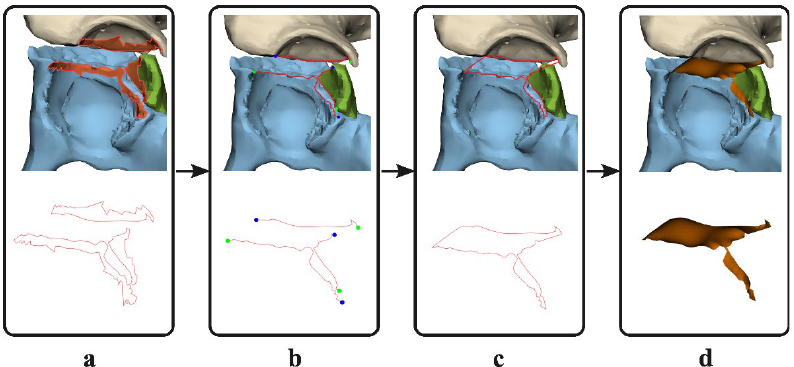
Figure 1. Method for determining the three-dimensional (3D) gap area. ( a ) The surface on the edge of each fracture fragment (e.g., fracture line) is marked (top) and the contours of the surface are converted to curves (red, bottom). ( b ) The curves are cut so that only the fracture lines remain. ( c ) The fracture lines are connected to generate an enclosed curve. ( d ) A three-dimensional surface, the 3D gap area, is generated based on the closed curve of the fracture lines (orange).